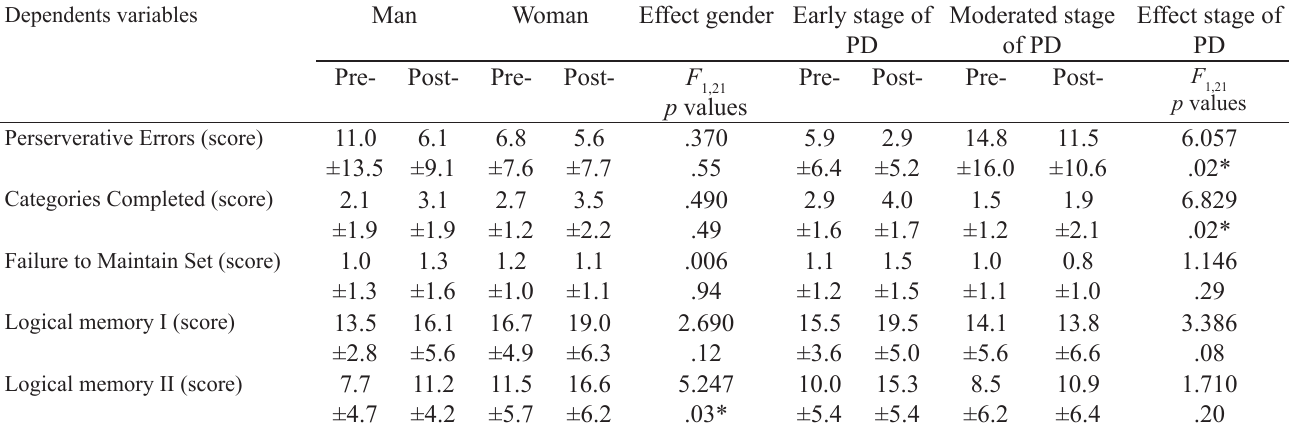
Table 2. Means ± standard deviations of the dependent variables for each group (gender: man and woman, stage of disease: early and moderated stage). ANOVA F and p effect